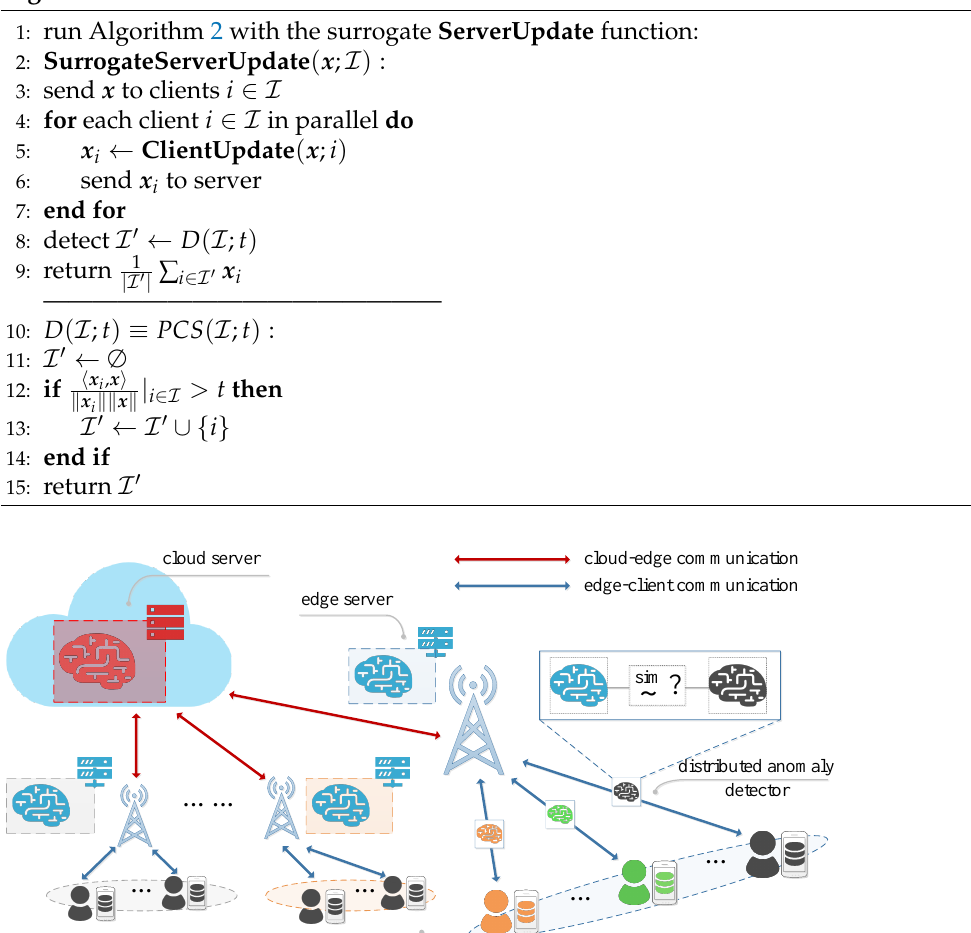
Algorithm 3 R-HFL: Robust Hierarchical FL.